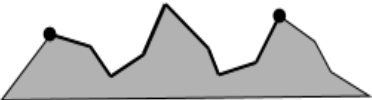
Figure 2. The Texture-based drawing method